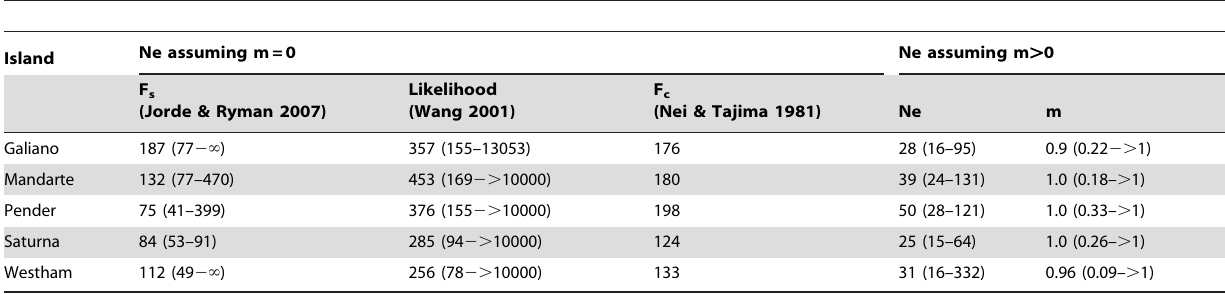
Table 4. Estimates of effective population size (Ne) and migration rate (m) of Malacosoma californicum pluviale populations based on temporal samples from surveys in 2003 and 2011.